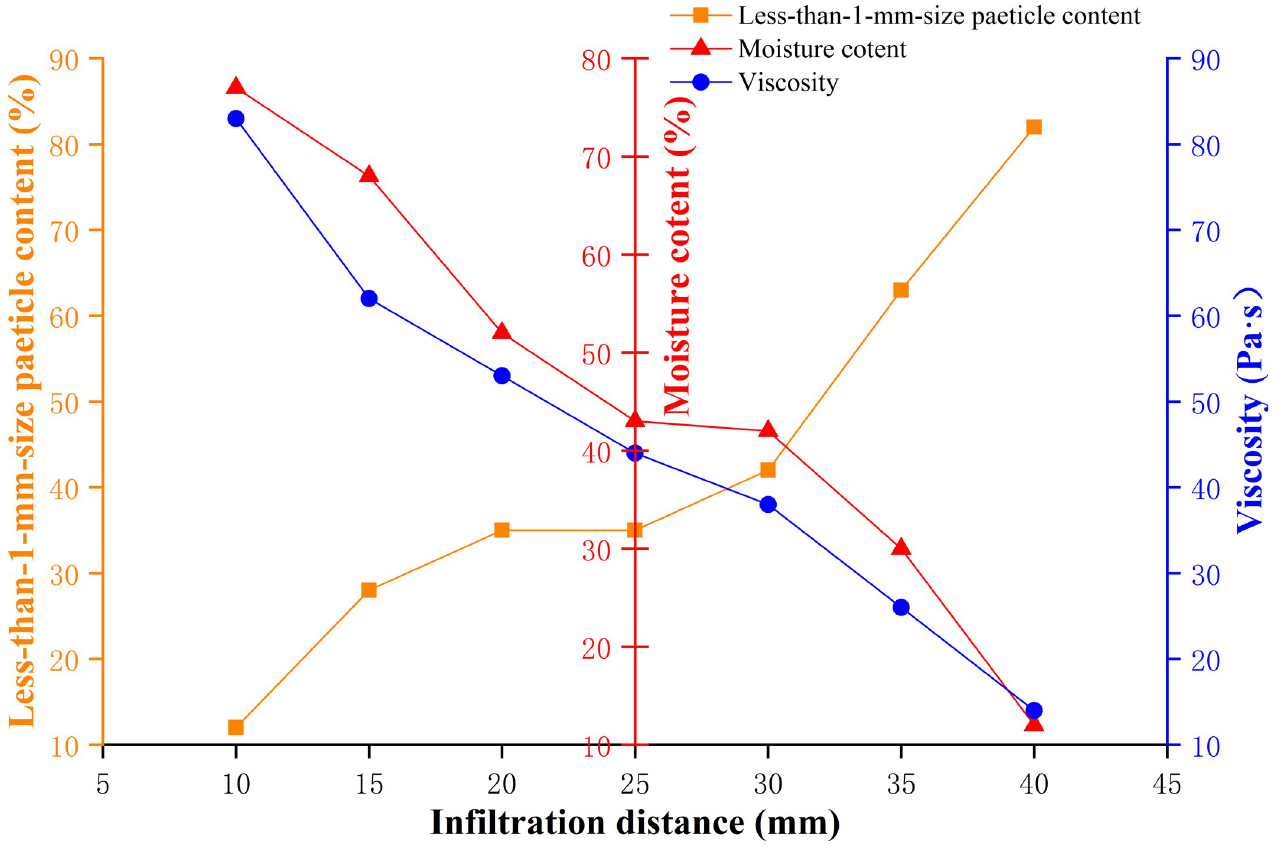
Fig 20. Effects of mud viscosity, water content and particle content smaller than 1 mm on the infiltration distance of a mud film.